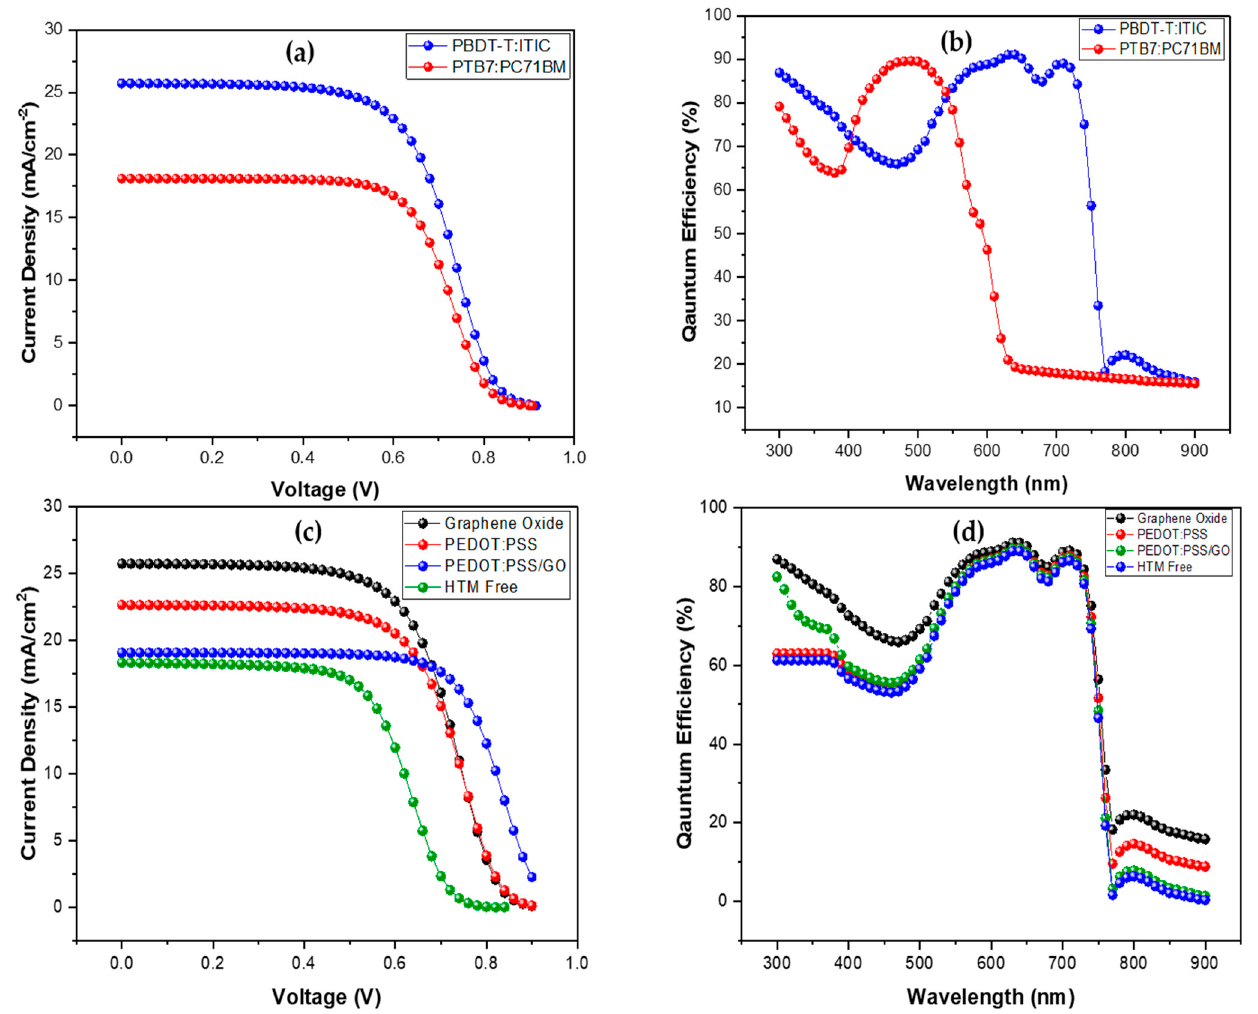
Figure 2. ( a ) Short-circuit current density comparison of different designed absorber layers; ( b ) quantum efficiency comparison of different designed absorber layers; ( c ) short-circuit current density comparison of different designed HTM layers; and ( d ) quantum efficiency comparison of different designed HTM layers.